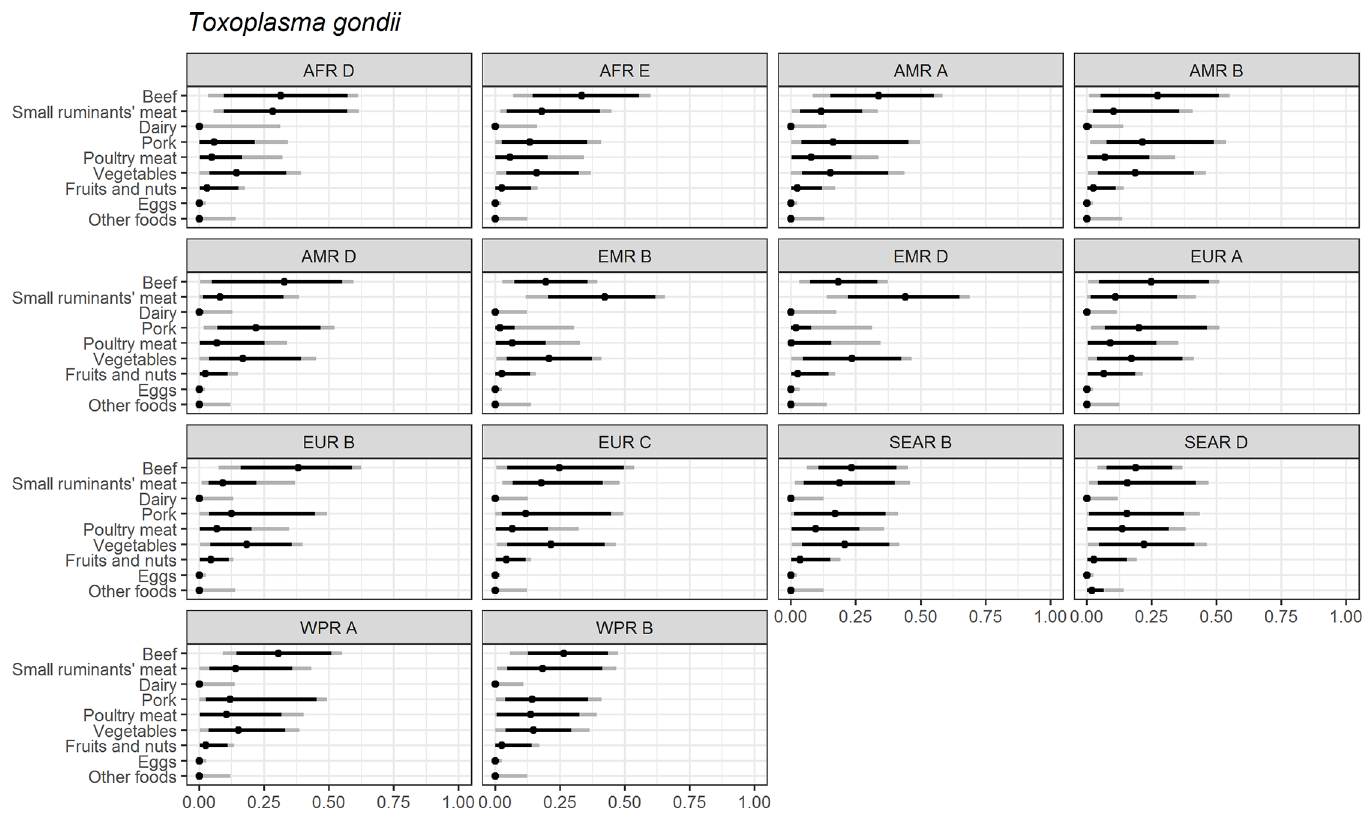
Fig 10. Toxoplasma gondii . Proportion of foodborne disease attributable to specific foods: Median estimate, and 90% and 95% uncertainty intervals by parasite and subregion. “Small ruminants’ meat” was listed as “Goat, lamb and other small ruminants’ meat” in the expert elicitation instrument. The X-axis labels are percentages. The dot represents the medianestimate; the dark black line, the 90% uncertainty interval; and the gray line the 95% uncertainty interval.